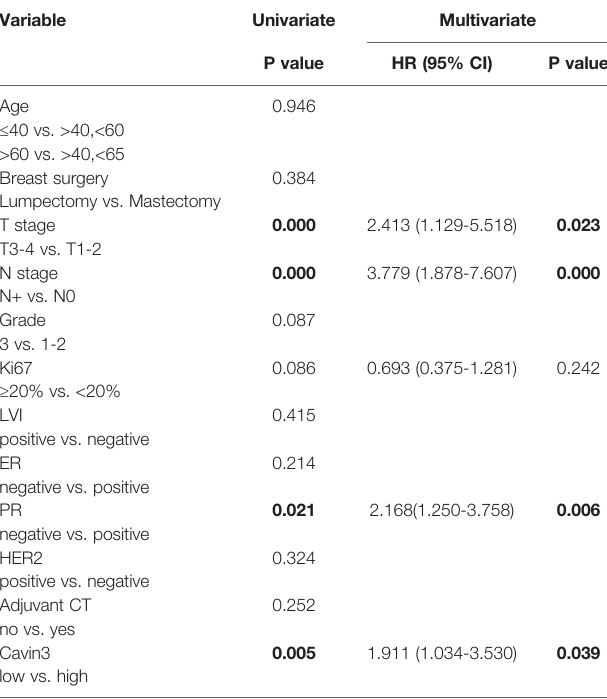
TABLE 2 | Univariate and Multivariate analysis of factors for distant metastasis- free survival (DMFS).